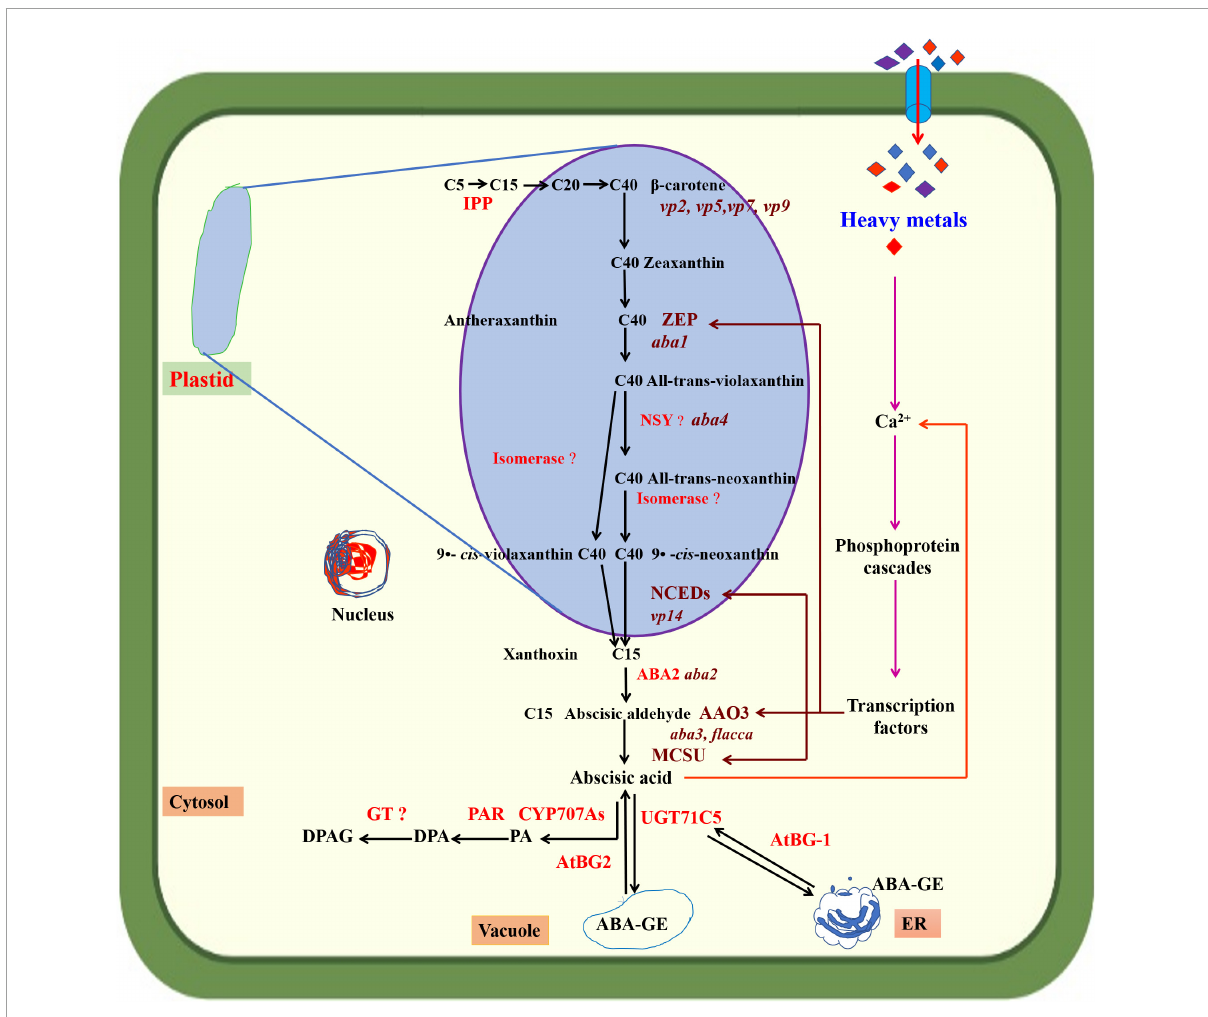
FIGURE1 Abscisic acid (ABA) biosynthesis in plant cells. Endoplasmic reticulum (ER). The precursor of ABA in plants is (C40) β -carotene. Isopentenyl pyrophosphate (IPP) converts C5 to C15 and continues to C40. β -carotene converts C40 to xanthoxin (C15) in plastids and cytosol. Zeaxanthin epoxidase (ZEP), neoxanthin synthase (NYS), 9- cis -epoxycarotenoid dioxygenase (NCEDs), phasic acid (PA), dihydrophaseic acid (DPA), PA reductase (PAR), DPA-4- β -D-glucoside (DPAG), UDP-glucosyltransferase (UGT) encoded by (UGT71C5), cytochrome P450 monooxygenase (P450) encoded by (CYP707As), glycosyltransferase (GT), β -glucosidase encoded by (AtBG1 and AtBG2), ABA-glucose ester (ABA-GE), abscisic aldehyde oxidase (AAO3), and MCSU, molybdenum cofactor